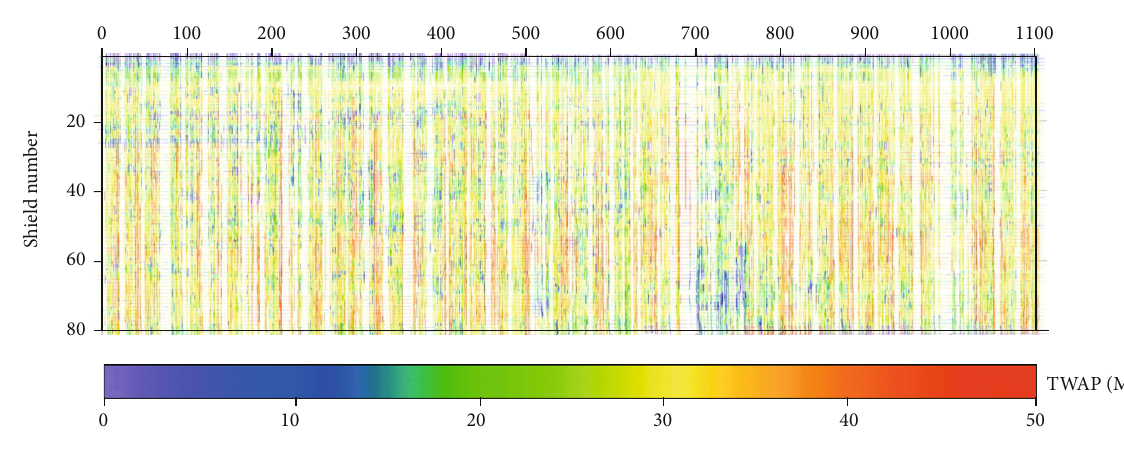
Figure 5: TWAP data in 600 supporting cycles of the shields. Table 1: Descriptive statistics of inputs and